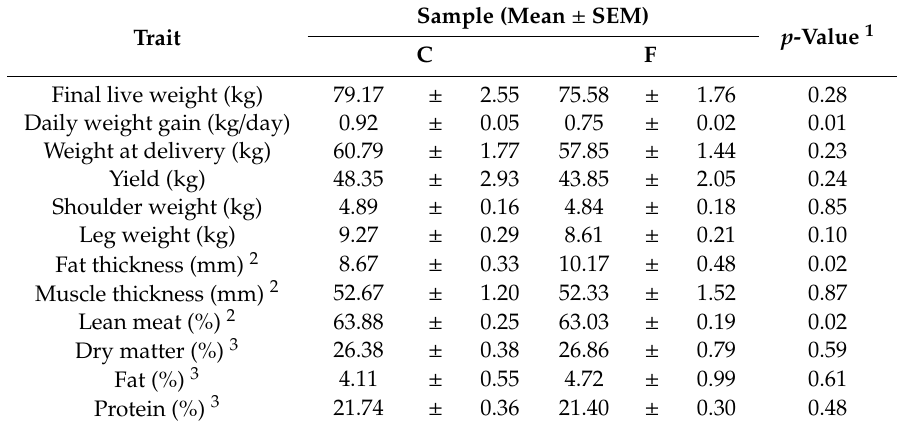
Table 3. Performance characteristics of pigs fed either a standard diet (C) or a diet enriched with 8% fish oil (F).